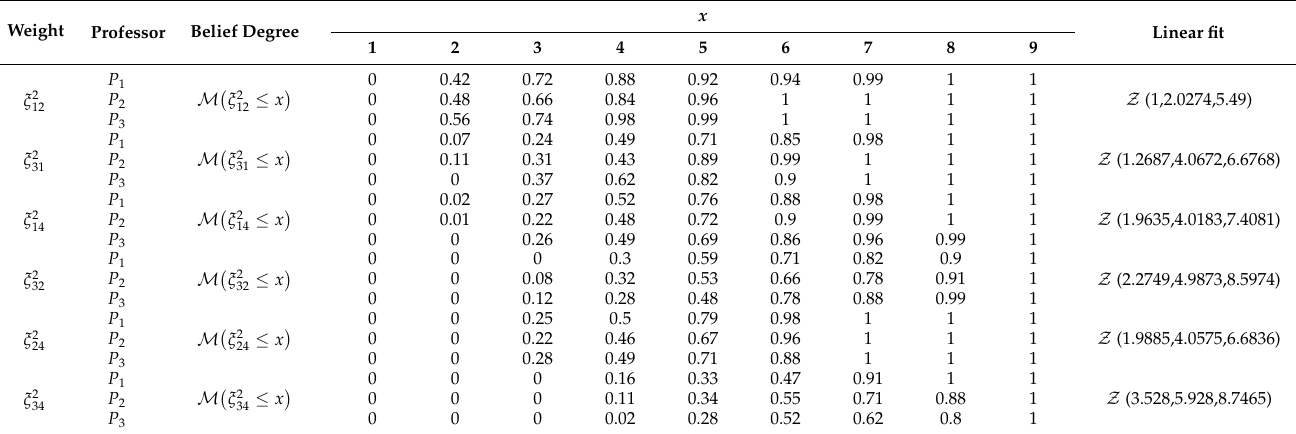
Table 6. The collated data for criteria C 21 , C 22 , C 23, and C 24